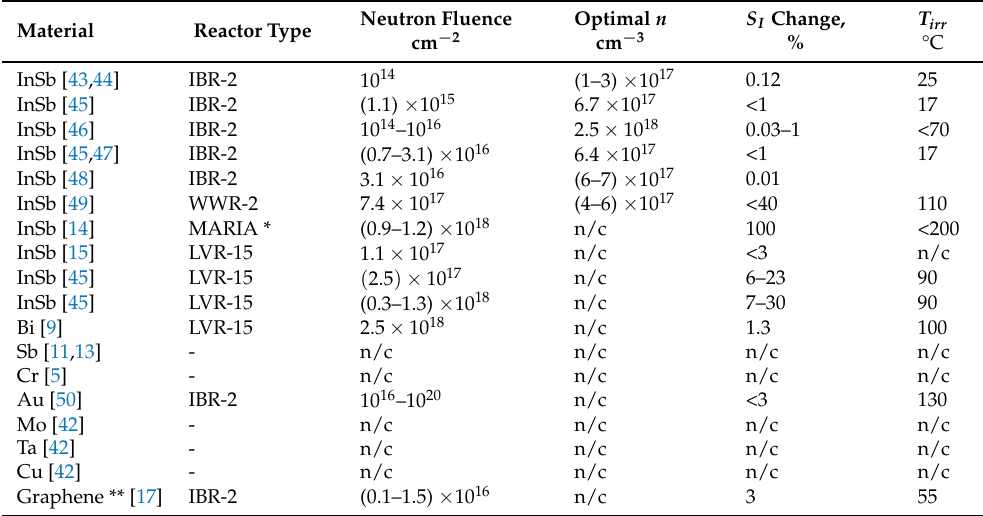
Table 2. Summary of the most important results for the NR resistance of materials for the construction of Hall